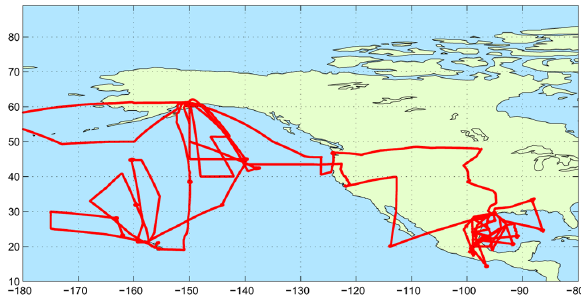
Fig. 7. Locations of measurements for INTEX-B flights, February– May